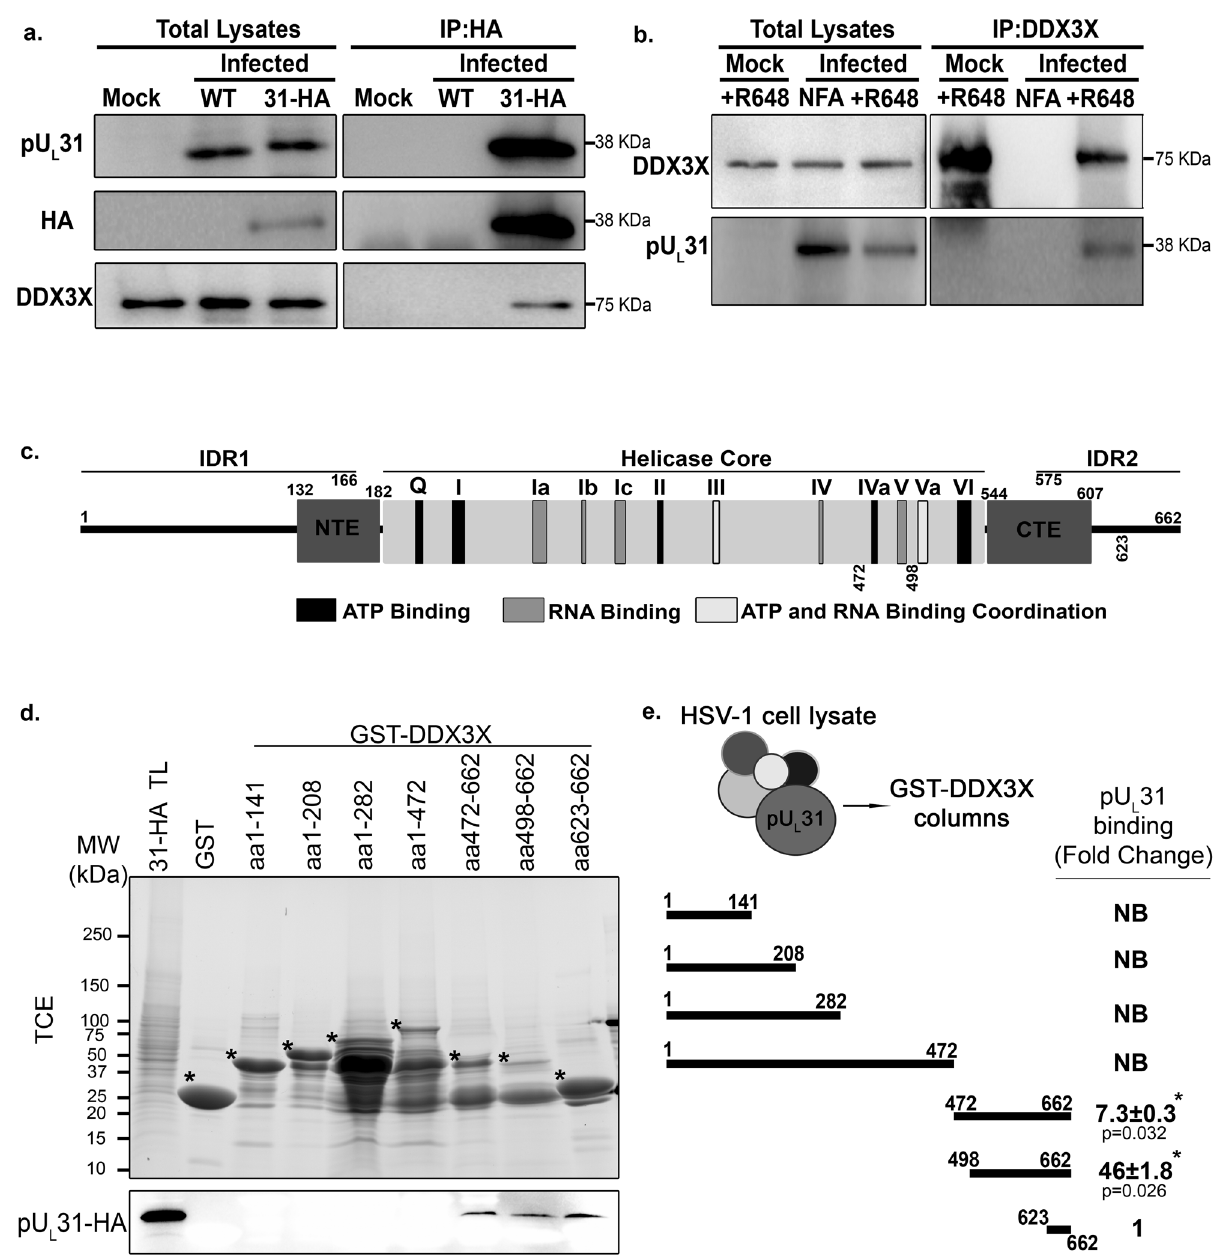
Fig. 3 The DDX3X carboxyl tail DDX3X physically interacts with the HSV-1 nuclear egress protein pU L 31. The interaction of DDX3X and pUL31 was assessed using co-IP. a HeLa cells were either mock-treated or infected with wild-type strain F virus (negative controls) or with HA-tagged pU L 31 virus at an MOI of 5 for 12 hpi. Cells were lysed and HA-tagged pU L 31 pulled down using anti-HA agarose beads. Total lysates and eluates were analyzed by WB by probing pU L 31 (anti HA or pU L 31) and DDX3X (anti-human DDX3 rabbit R648 polyclonal serum) as indicated to the left of the blots. b The reverse co-IP was also performed with HeLa cells either mock-treated or infected as above but by precipitating DDX3X (anti-human DDX3 rabbit R648 polyclonal serum and protein A agarose beads). The presence of DDX3X and pU L 31 in the eluates were assessed by Western blot using anti-DDX3X R648 or anti-pU L 31 as shown to the left of those blots. c Schematic map of DDX3X showing its different domains and motifs (adapted from 103 ). IDR, NTE and CTE represent intrinsically disordered domains, N- and C-terminal extensions respectively. The helicase core (residues 182-544) represents the minimally active portion of DDX3X. All conserved DDX3X motifs are colour coded as de fi ned by the legend on the fi gure. These motifs modulate ATP and RNA binding or the coordination between the two functions. d Recombinant GST-tagged DDX3X constructs or a GST alone control were captured on glutathione Sepharose 4B beads. HeLa infected lysates (HA-tagged pU L 31 virus, MOI of 5, 24 hpi) were pre-cleared on the GST preloaded glutathione Sepharose beads then incubated with the various enriched GST-DDX3X constructs for 3 h. The beads were boiled in sample buffer to release the bait. Samples were analyzed on 5 – 20% gradient SDS-PAGE containing 0.5% TCE. The level of the bead bound GST-tagged constructs was analyzed by UV exposure (TCE panel) on a ChemiDoc (BioRad). Binding of pU L 31 was evaluated by Western blotting using a HA-tag antibody (bottom panel). Stars highlight the position of each GST construct. TL represents total lysates prior to its loading on the beads. e Quanti fi cation of pU L 31 binding to the beads for each DDX3X construct (drawn schematically). Binding was calculated by normalizing the HA-tagged pUL31 Western blot signal to the TCE signal for each GST chimera. Fold changes were measured by arbitrarily setting the binding to GST-DDX3X aa 623-662 to one. Absence of binding is de fi ned as NB (no binding). ±Standard error of the means (bilateral Student T -tests; * p < 0.05). The fi gure represents four independent